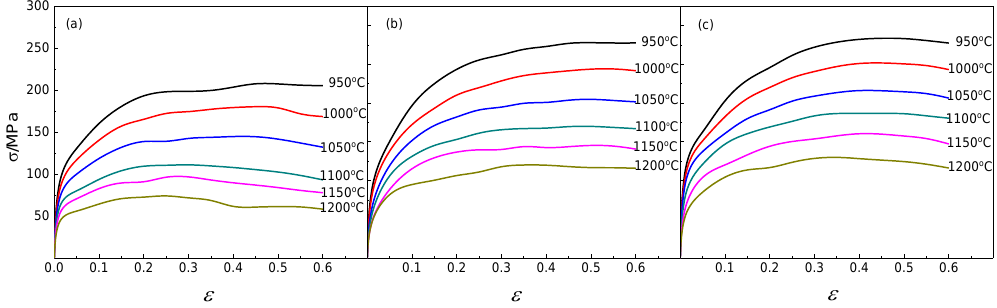
Figure 1. Flow stress-strain curves of BSTMUF601 super-alloy under different strain rates: ( a ) 0.2 s −1 ; ( b ) 5 s −1 ; ( c ) 10 s −1 .